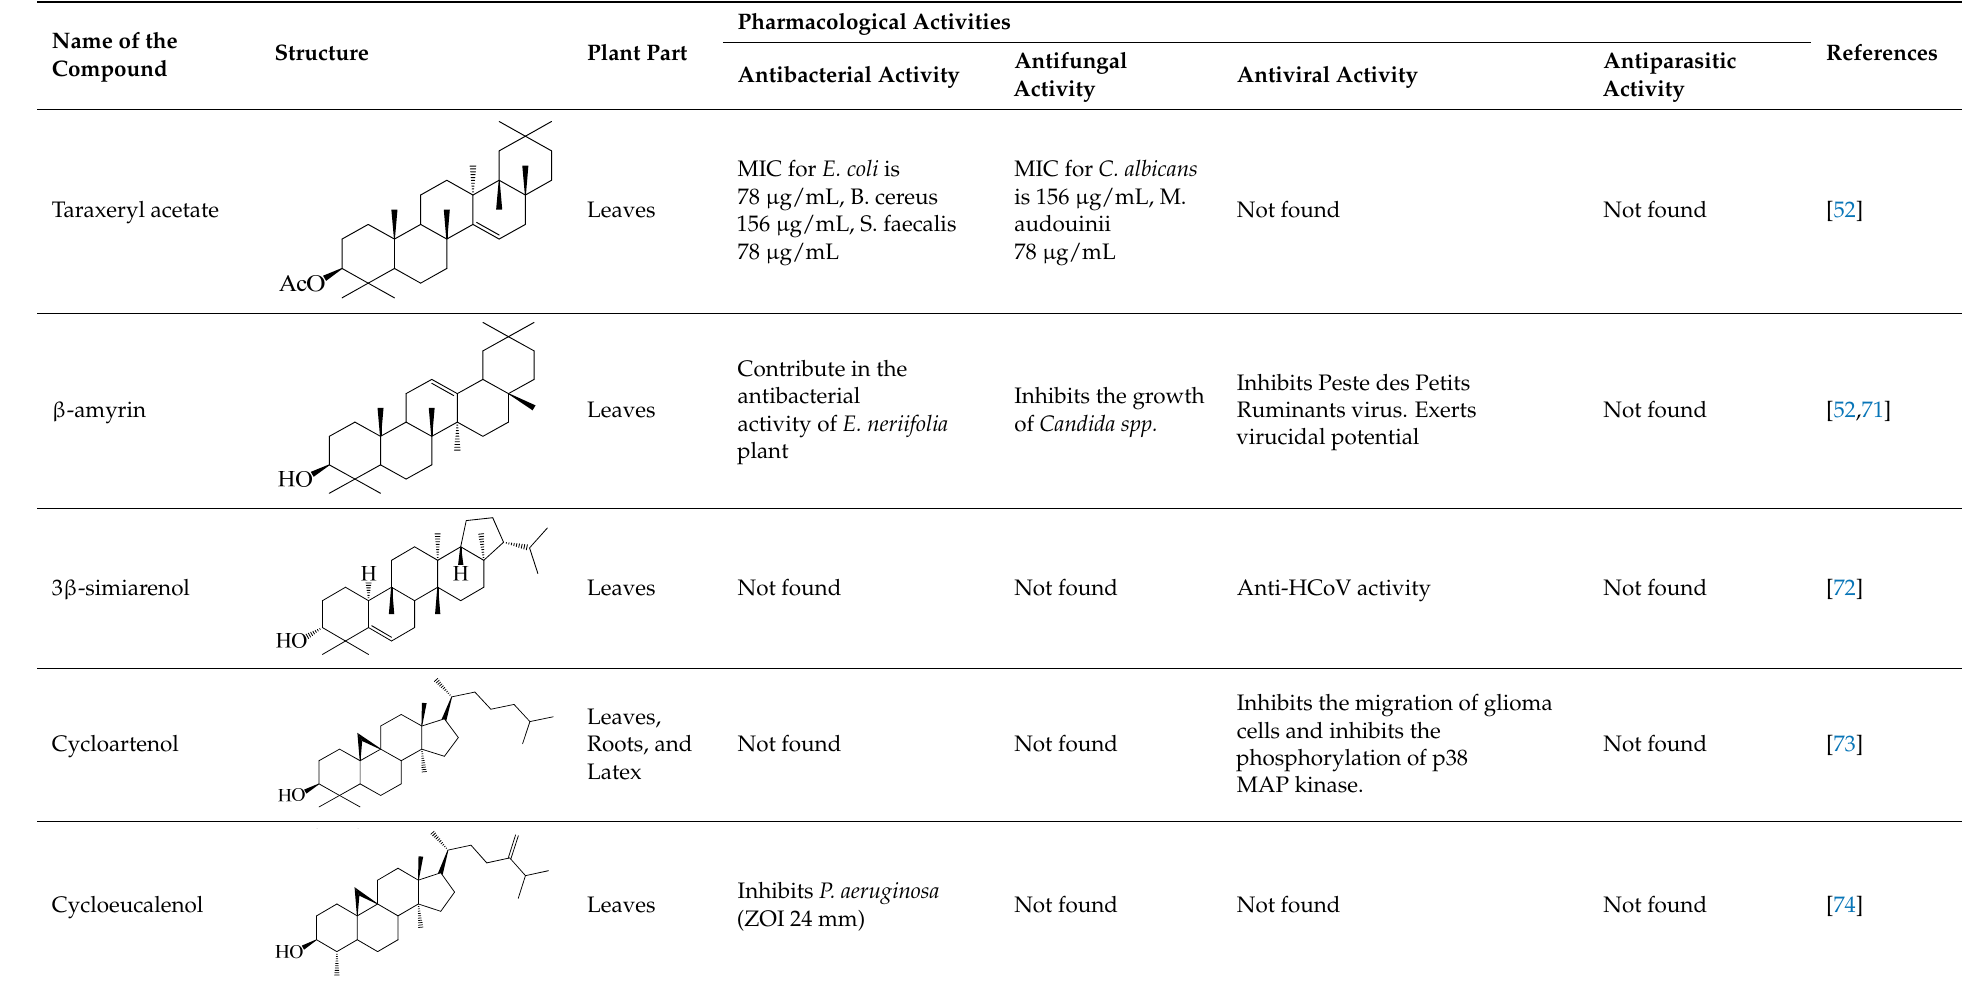
Inhibits the migration of glioma cells and inhibits the phosphorylation of p38 MAP